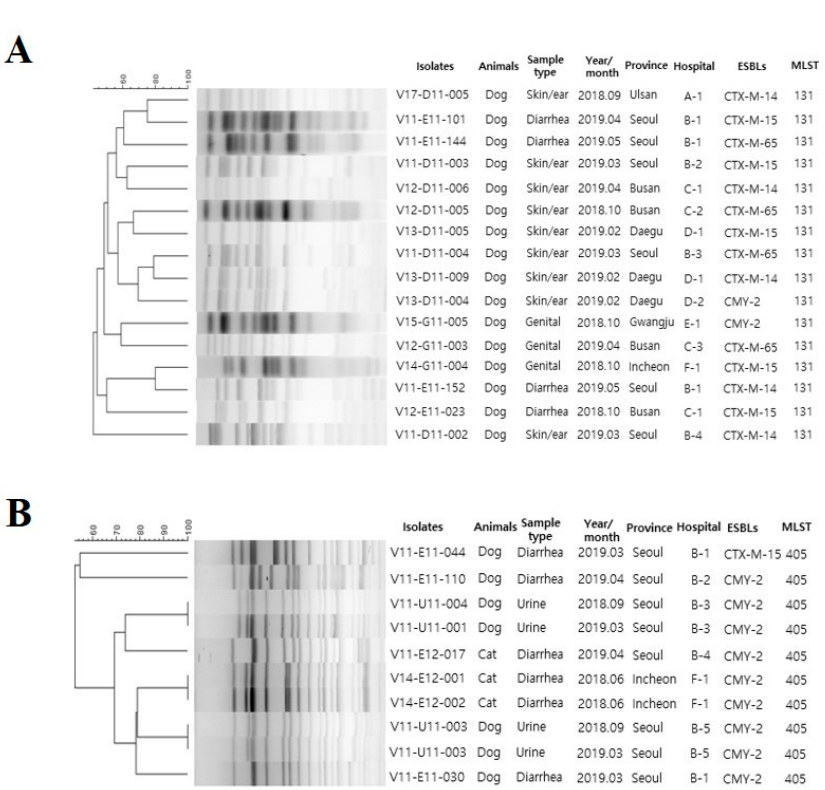
Figure 1. PFGE patterns E. coli ST131 ( A ) and E. coli ST405 ( B ) isolated from diseased dogs and cats in Korea.